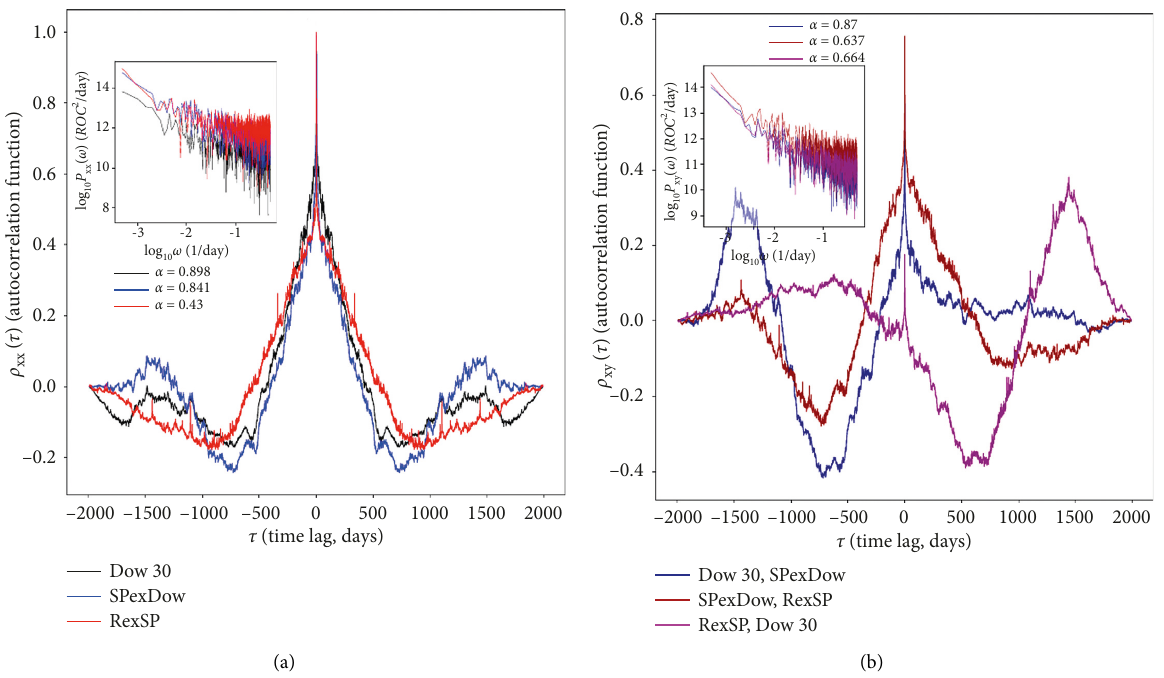
Figure 4: Autocorrelation (a) and cross-correlation (b) decay functions for realized opportunity cost (ROC) computed over three disjoint sets of trading symbols. ROC has a strong positive autocorrelation for hundreds of trading days, and two of the three sets of trading symbols exhibit similar cross-correlation